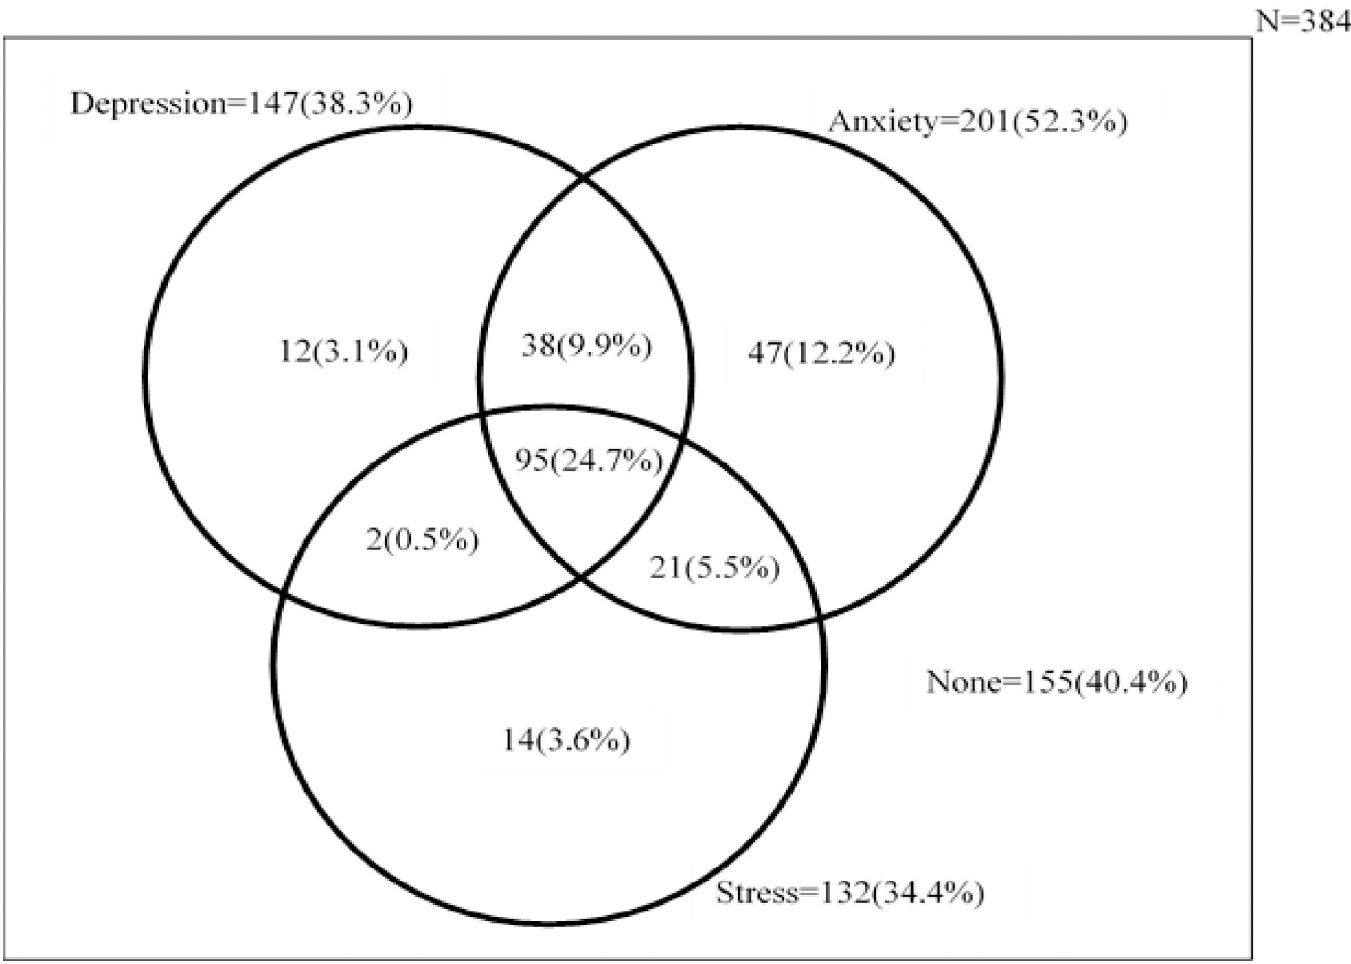
Fig 1. Prevalence of mental health conditions among